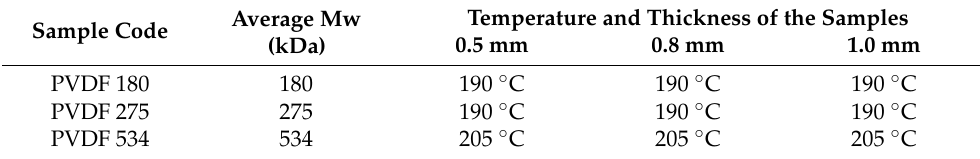
Table 1. Summarized labeling of the prepared